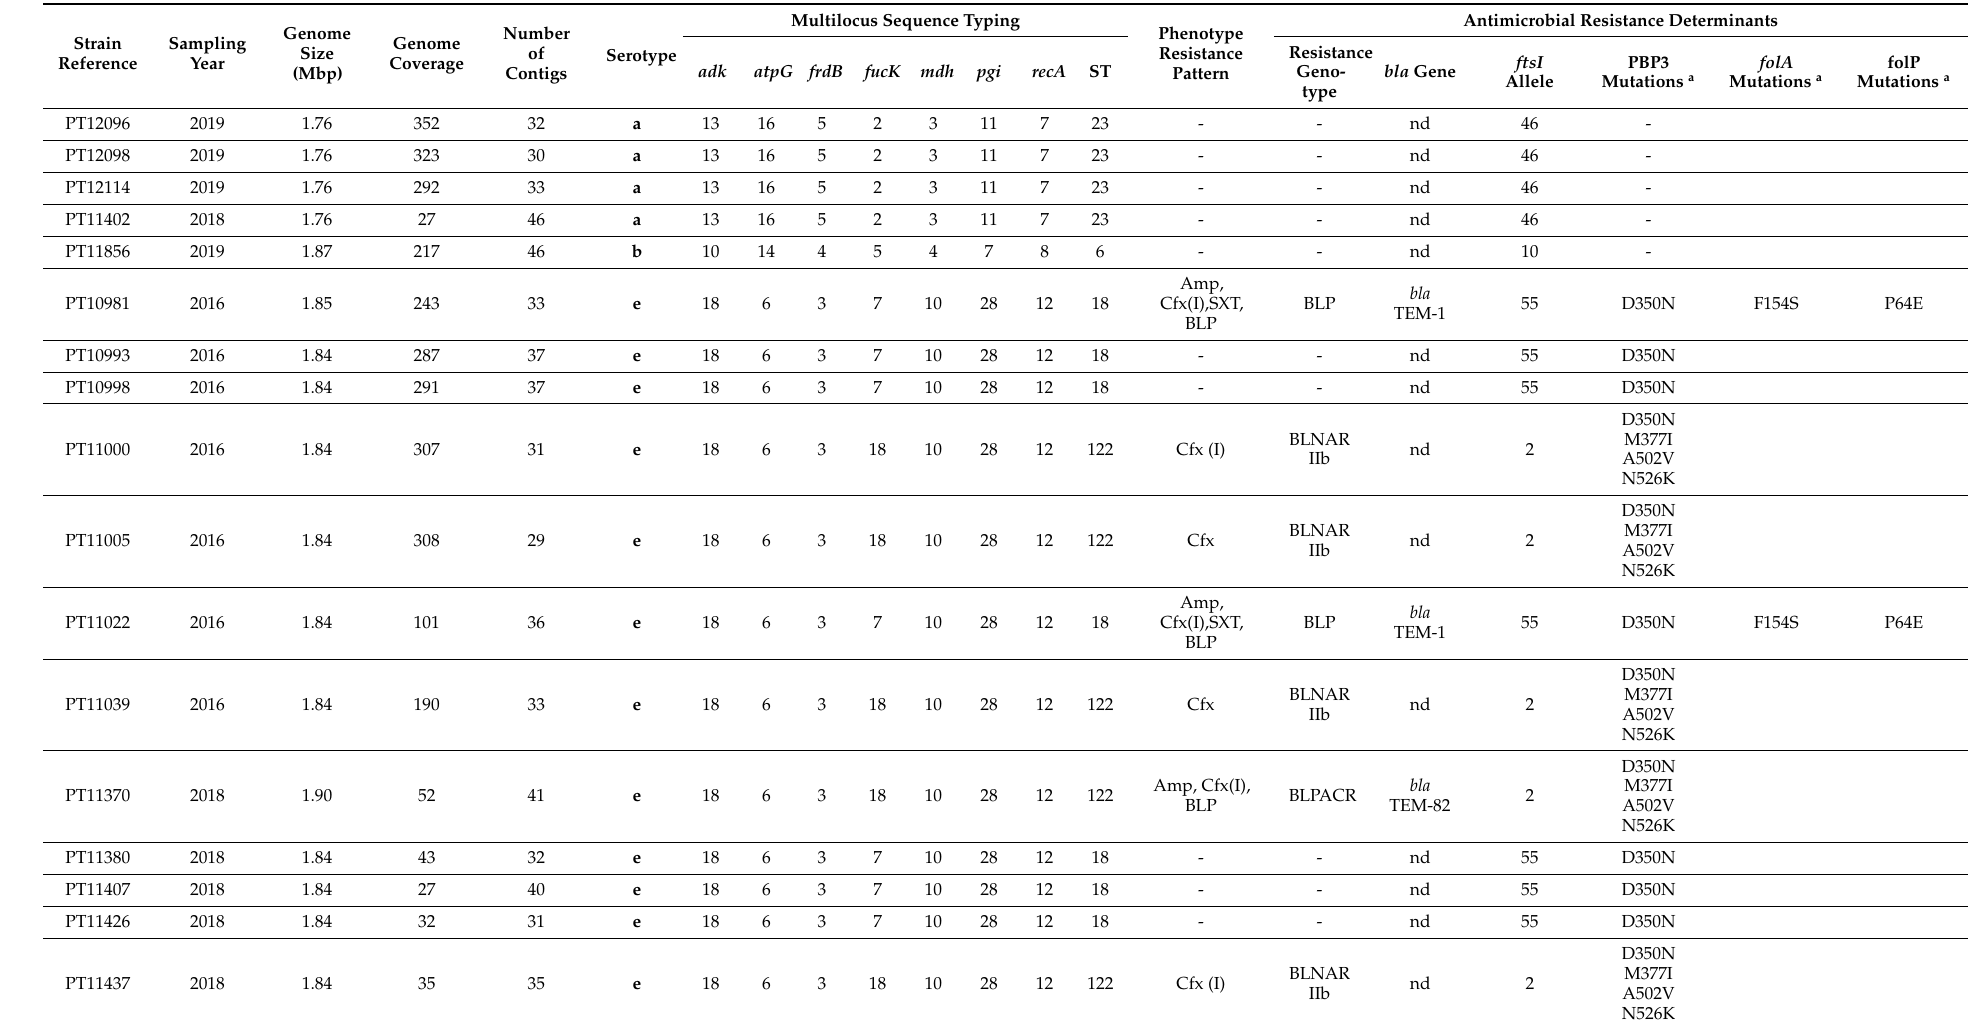
Table 4. H. influenzae isolates analyzed by whole-genome